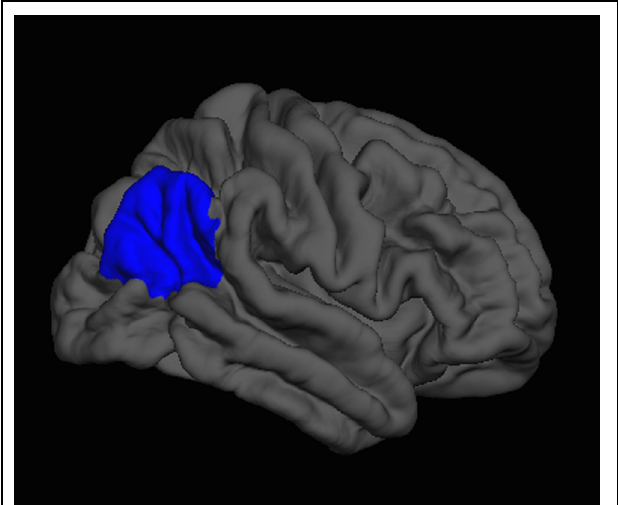
FIGURE 3 | FreeSurfer rendering of the right hemisphere pial surface with the inferior parietal region indicated in blue, showing decreased cortical thickness in this region associated with increased fluency on the Foresight task.